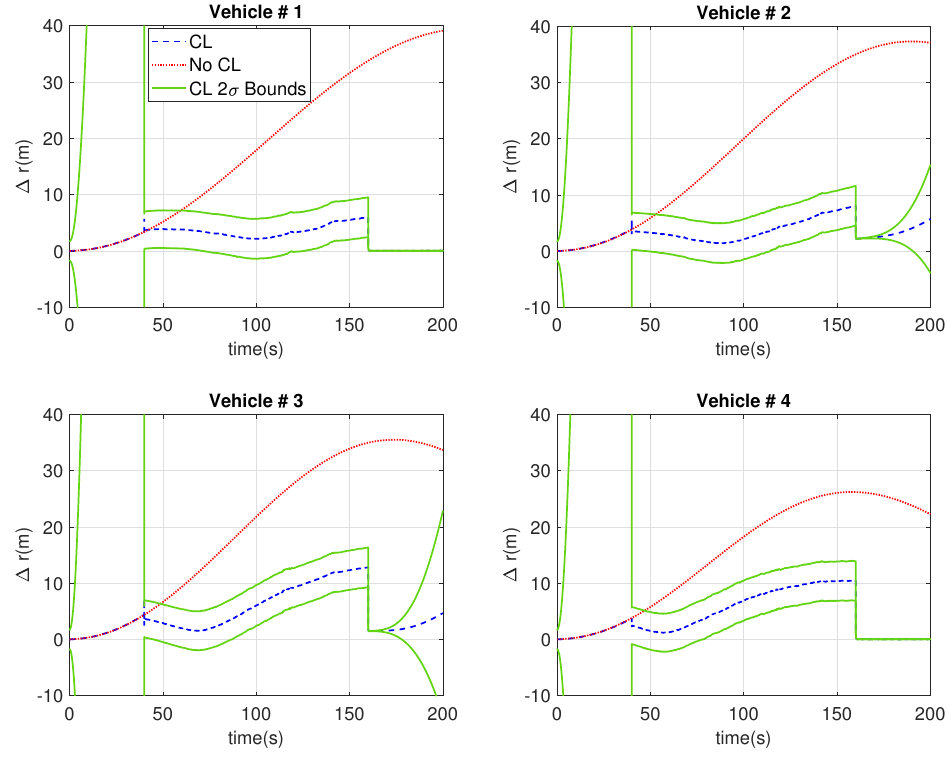
Figure 5. Time history of vehicle position error norm in the test